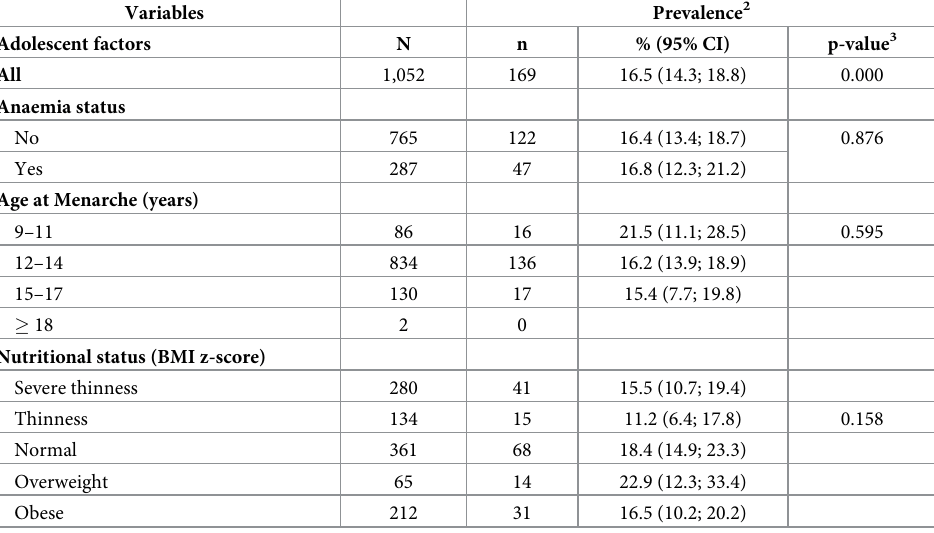
Table 1. Prevalence of CMD 1 among Indonesian girls aged 15–19 years old according to adolescent-related and household factors (Riskesdas 2018). Variables Prevalence